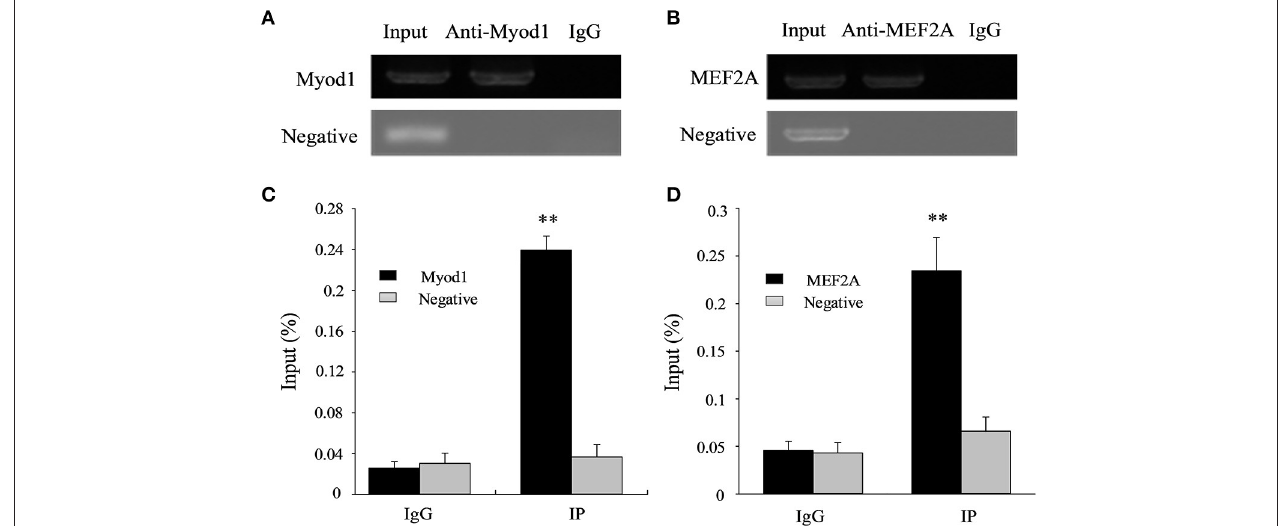
FIGURE 7 | Chromatin immunoprecipitation (ChIP) assay of Myod1 and MEF2A binding to the LATS 1 promoter in vivo . ChIP-PCR products of Myod1 (A) and MEF2A (B) input and immunoprecipitated were amplified and identified by 1% agarose electrophoresis from muscle. ChIP-qPCR assays detected the enrichment of DNA fragments in samples immunoprecipitated with Myod1 (C) and MEF2A (D) antibodies. We used the input was total chromatin from muscle, while the products from rabbit antiimmunoglobulin G (IgG) and an intragenic DNA fragment of LATS 1 exon 3. “**” p < 0.01.